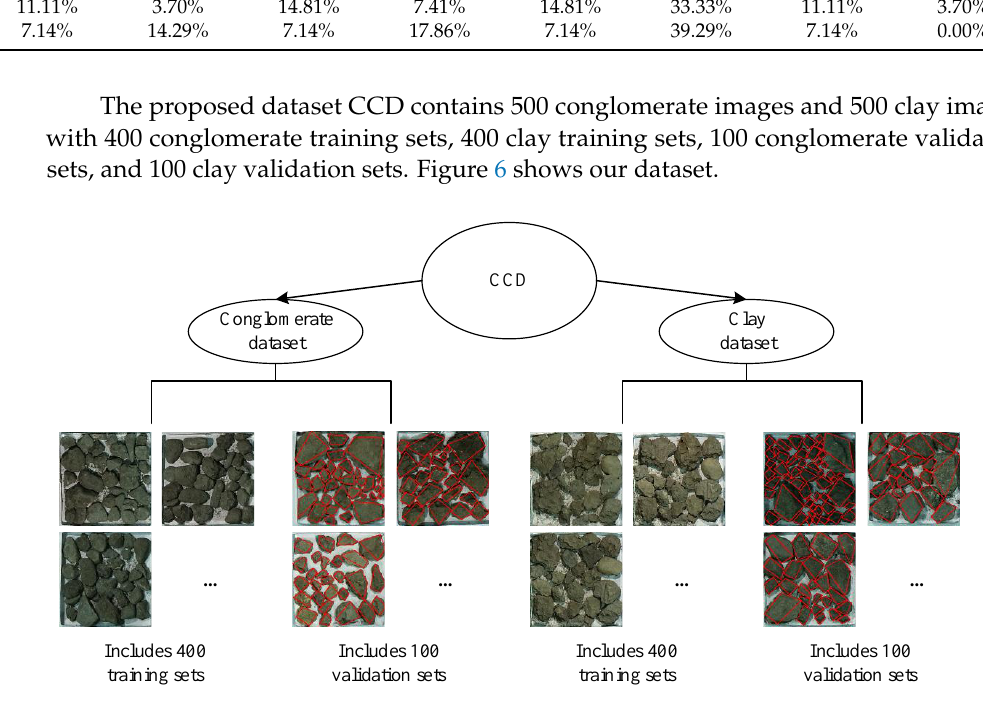
Figure 6. The illustration of our proposed dataset